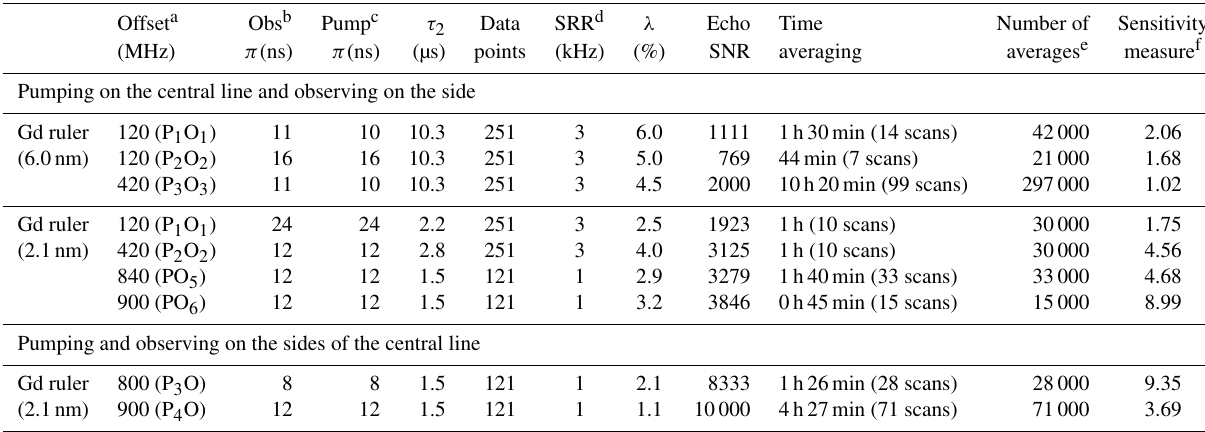
Table 1. Settings for W-band DEER measurements on both rulers and the associated modulation depths obtained by fitting the DEER data with DeerAnalysis (2019) (Jeschke et al., 2006). The interpulse delay τ 1 was set to 300ns for all experiments. To allow different DEER measurements to be compared more easily we take our sensitivity measure as the echo SNR multiplied by the modulation depth divided by the square root of the total number of measurements. It should be noted that this does not take into account differences in excitation bandwidth of pump and observer pulses.